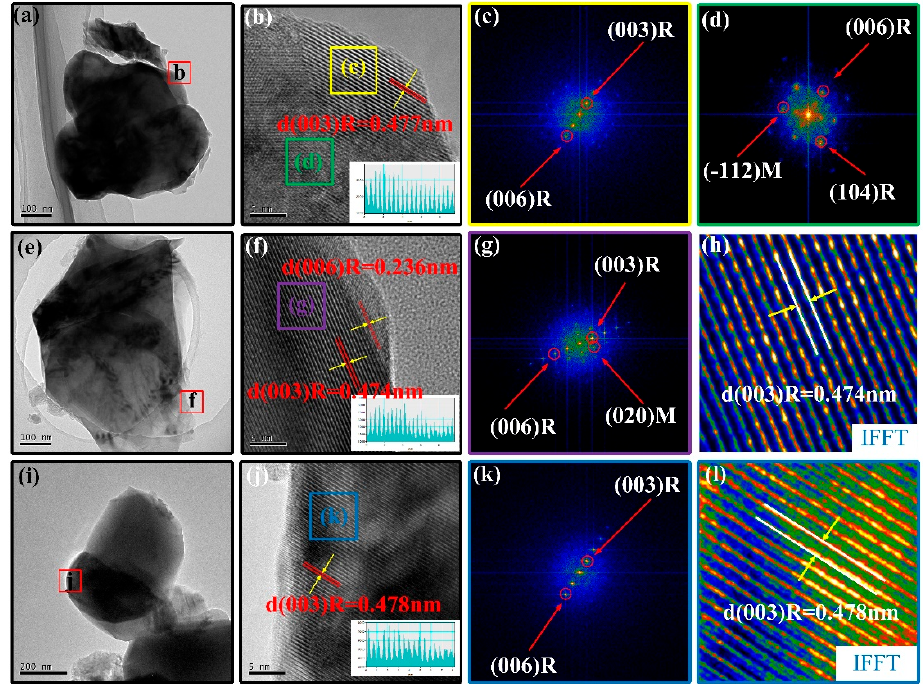
Figure 3. TEM and HRTEM images: ( a , b ) SLC; ( e , f ) SLS; ( i , j ) OCP; ( c , d ) fast Fourier transform (FFT) of the corresponding area in ( b ); ( g , h ) FFT and inverse fast Fourier transform (IFFT) of the corresponding area in ( f ); ( k , l ) FFT and IFFT of the corresponding area in ( j ). The indexes marked by R and M are related to the rhombohedral (R 3(cid:3364) m) phase and monoclinic Li 2 MnO 3 (C2/m) phase.